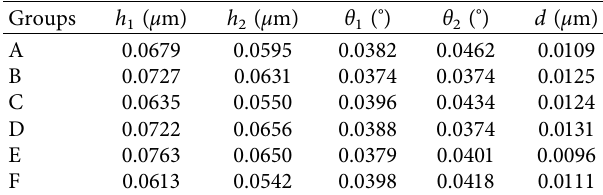
Table 5: Relative errors of trueness. Groups